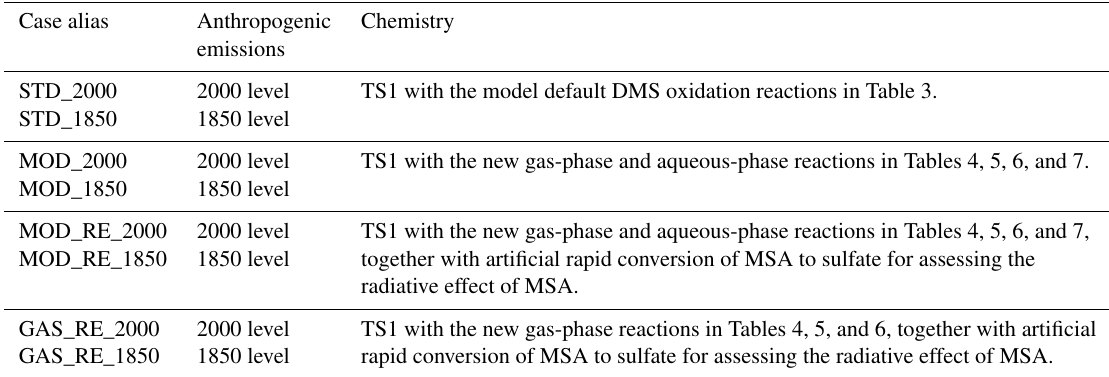
Table 1. Configuration of key simulation cases in this study. Case alias Anthropogenic TS1 with the model default DMS oxidation reactions in Table 3. TS1 with the new gas-phase and aqueous-phase reactions in Tables 4, 5, 6, and 7. 2000 level TS1 with the new gas-phase and aqueous-phase reactions in Tables 4, 5, 6, and 7, 1850 level together with artificial rapid conversion of MSA to sulfate for assessing the radiative effect of MSA. 2000 level TS1 with the new gas-phase reactions in Tables 4, 5, and 6, together with artificial GAS_RE_1850 1850 level rapid conversion of MSA to sulfate for assessing the radiative effect of